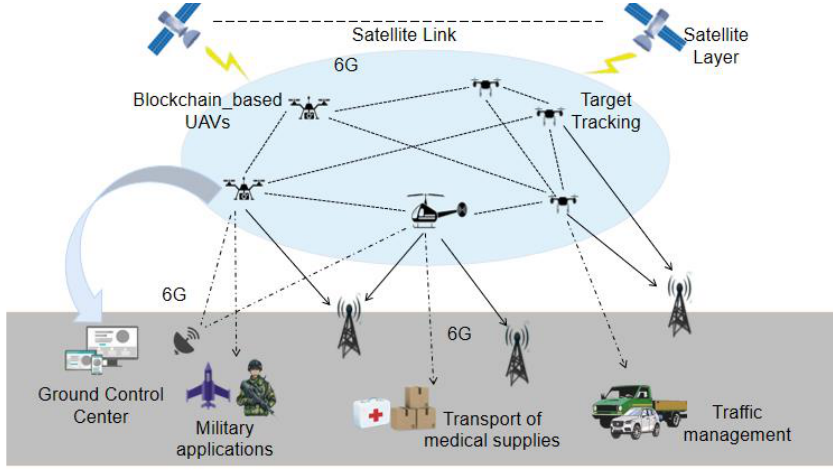
Figure 1. Diverse application scenarios of 6G and blockchain-based UAV communication.